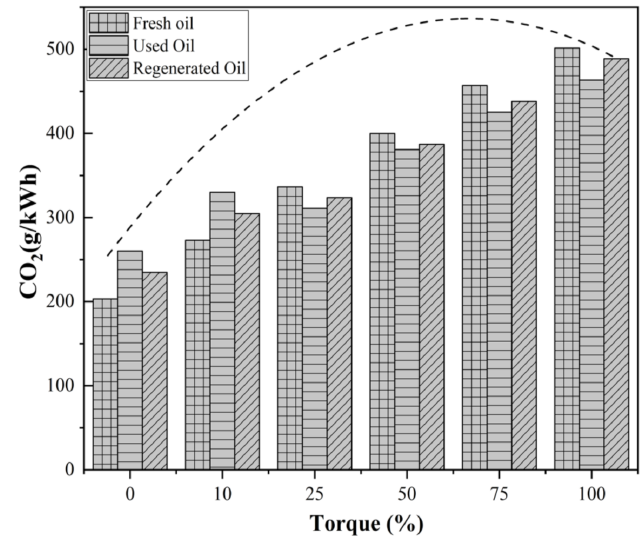
Figure 9. CO 2 emissions variations with torque